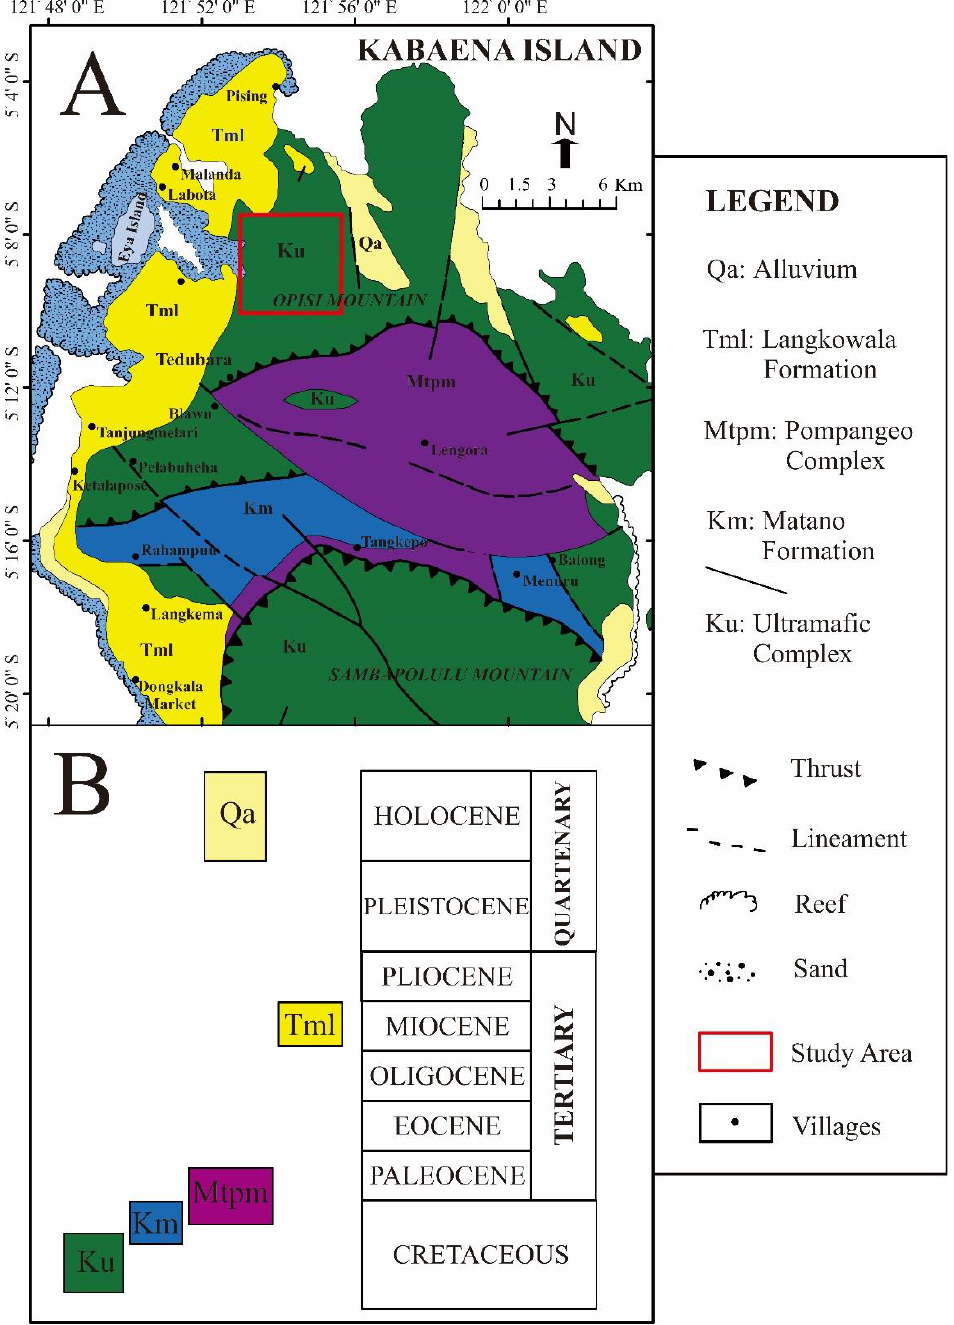
Figure 2. Geological map of the northern part of Kabaena Island showing the study area ( A ) and stratigraphy ( B ), (modified after Simandjuntak [34]). Light blue with dots area is inferred coral reef occurrence. See the text for the detailed description of the formation and complex.